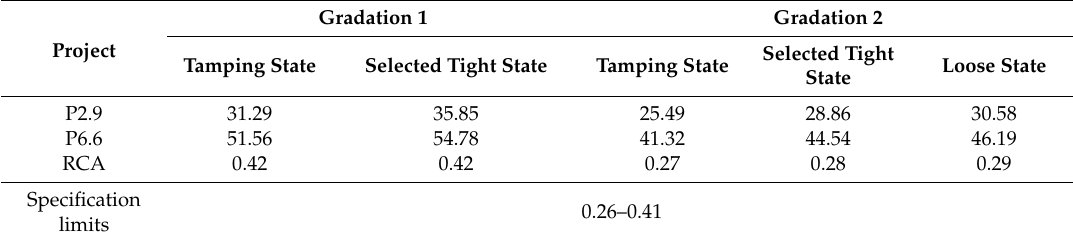
Table 11. R CA value in aggregate filling state.